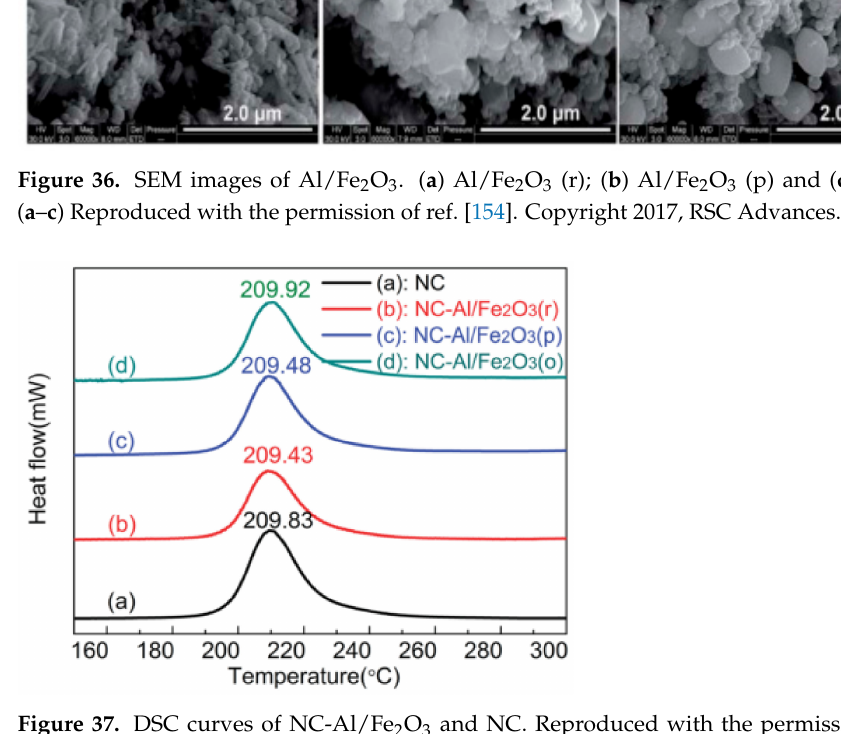
Figure 37. DSC curves of NC-Al/Fe 2 O 3 and NC. Reproduced with the permission of ref. [154]. Copyright 2017, RSC Advances.